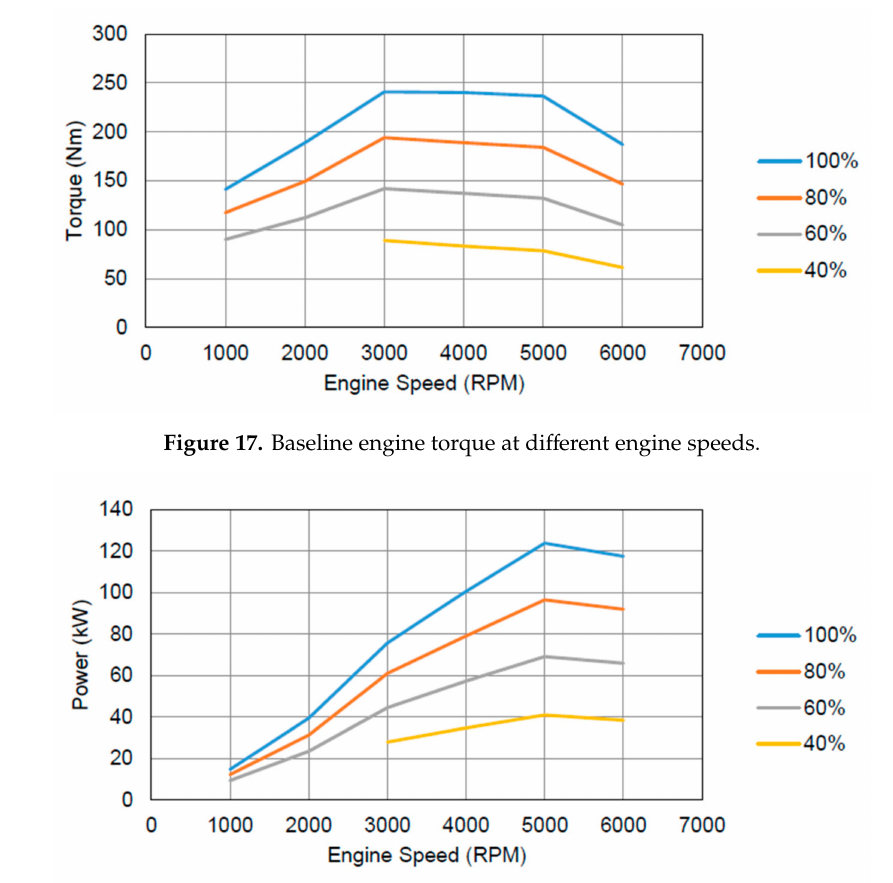
Figure 18. Baseline engine brake power at di ff erent engine